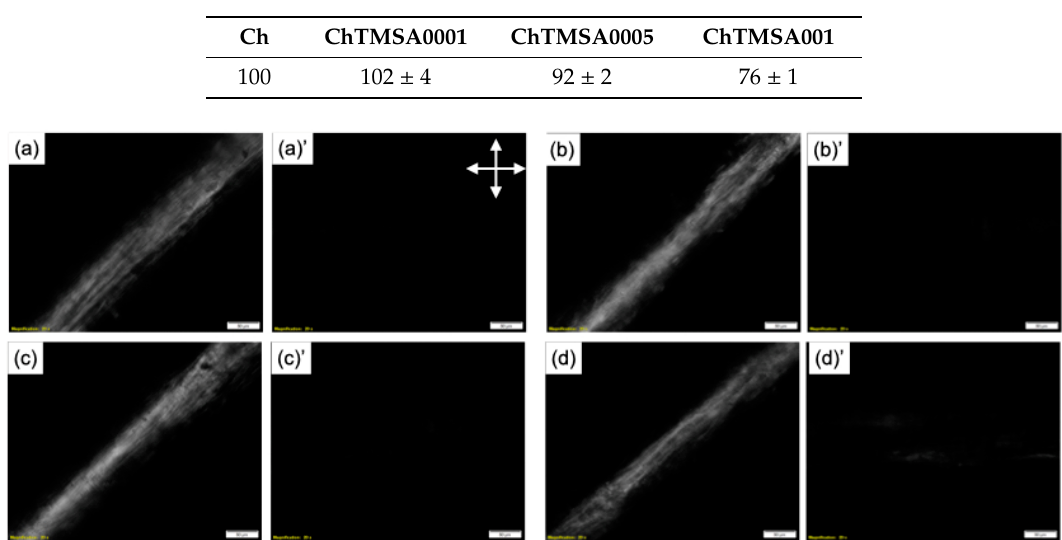
Figure 5. Optical microscope images of the chitosan − TMSA microfibers obtained with crossed nicols at 45° ( a – d ) and 90° ( a ) ′ –( d ) ′ . ( a ) and ( a ) ′ Ch; ( b ) and ( b ) ′ ChTMSA0001; ( c ) and ( c ) ′ ChTMSA0005; and ( d ) and ( d ) ′ ChTMSA001. The arrows indicate the direction of the nicols.